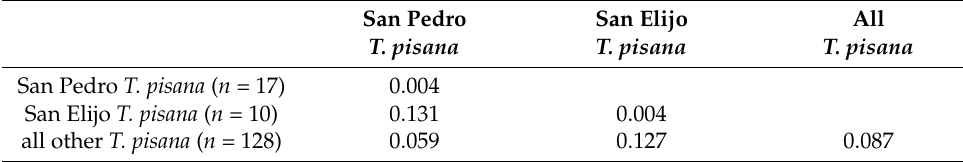
Figure 7. Haplotype networks and RAxML maximum likelihood phylogenies of Theba pisana mtDNA CO1 and 16S haplotypes and ITS2 sequences. ( A ) Median-joining 16S rRNA network of 17 T. pisana haplotypes from specimens collected in San Pedro, Los Angeles County, California, USA, ( B ) RAxML phylogeny based on concatenated mtDNA CO1 and 16S rRNA sequence data (1059 bp) from specimens collected in San Pedro, Los Angeles County, California (in yellow) with the outgroup Theba subdentata , GenBank acc. nos. MF564172 (CO1) and MF564126 (16S), from Souss-Massa, Morocco [57], ( C ) RAxML phylogeny based on partial ITS2 sequence data (836 bp) from specimens collected in San Pedro, Los Angeles County, California (in yellow) and San Elijo Lagoon Ecological Reserve, San Diego County, California (in pink) with T. pisana , GenBank acc. no. KR705081, from Tenerife, Canary Islands [59] and the outgroup Theba subdentata , GenBank acc. no. KJ458640, from Almería, Spain [58]; ( D ) Median-joining ITS2 network of 16 T. pisana sequences from San Pedro, Los Angeles County, California (in yellow) and San Elijo Lagoon Ecological Reserve, San Diego County, California (in pink) with T. pisana (KR705081) and T. subdentata (KJ458640) as in (C). In phylogenies, RAxML bootstrap support values ≥ 75 are followed by Bayesian posterior probabilities ≥ 0.90. In haplotype networks, circle size is proportional to the number of haplotypes in the dataset, and each hashmark represents a single nucleotide difference between haplotypes. For GenBank accession numbers, see Table 1. Table 2. Estimates of K2P genetic distance in Theba pisana CO1 mtDNA within and between sites in California (San Pedro, Los Angeles County and San Elijo Lagoon Ecological Reserve, San Diego County) and elsewhere in the world (see Figure